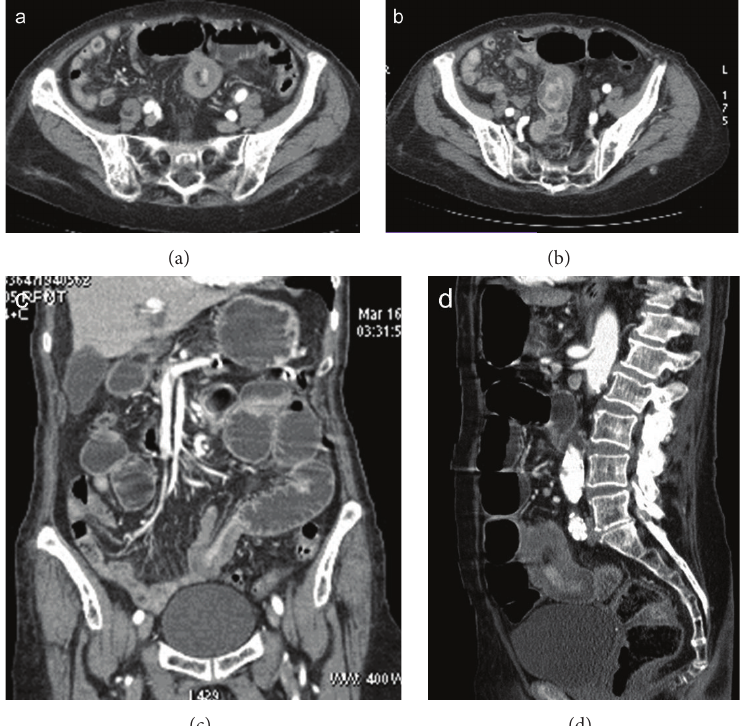
Figure 10: Enteroenteric (ileoileal) intussusception. Bowel wall of intussusception is thickened and enhanced. Signs of small bowel obstruction are seen on axial scans (a, b) and coronal (c) and sagittal (d)